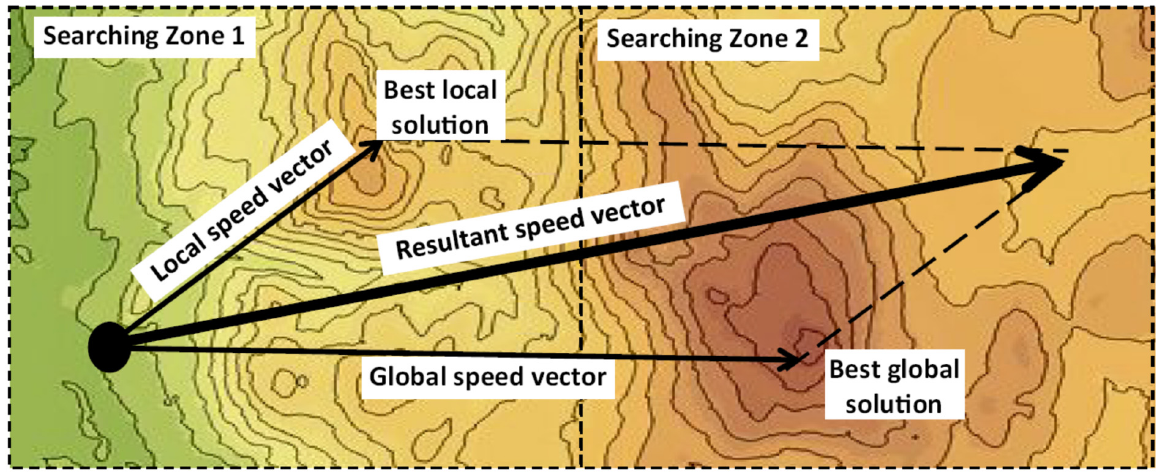
Figure 9. Main concept of local and global speed vectors in the PSO technique.